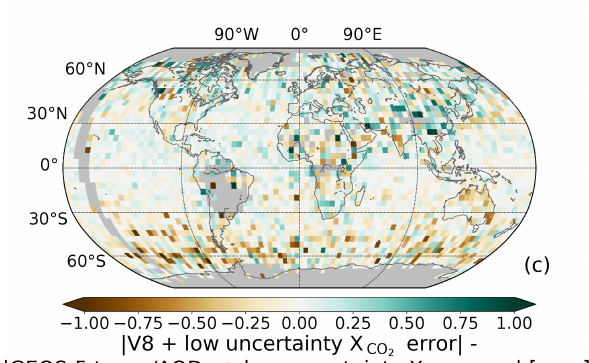
Figure 8. (a) The 4 ◦ × 4 ◦ binned absolute value of V8 X CO er- 2 ror against the model validation minus the absolute value of the GEOS-5 types and AODs with low-uncertainty X CO error against 2 the model validation. (b) The 4 ◦ × 4 ◦ binned absolute value of V8 X CO error against the model validation minus the absolute value of 2 V8 with low-uncertainty X CO error against the model validation. 2 (c) The 4 ◦ × 4 ◦ binned absolute value of V8 with low-uncertainty X CO error against the model validation minus the absolute value of 2 GEOS-5 types and AODs with low-uncertainty X CO error against 2 the model validation. Green grid cells represent an improvement relative to the model validation while brown grid cells represent a worse comparison to the model validation. Grey bins represent no